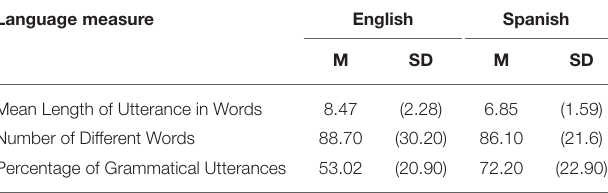
TABLE 2 | Language measures presented in means and standard